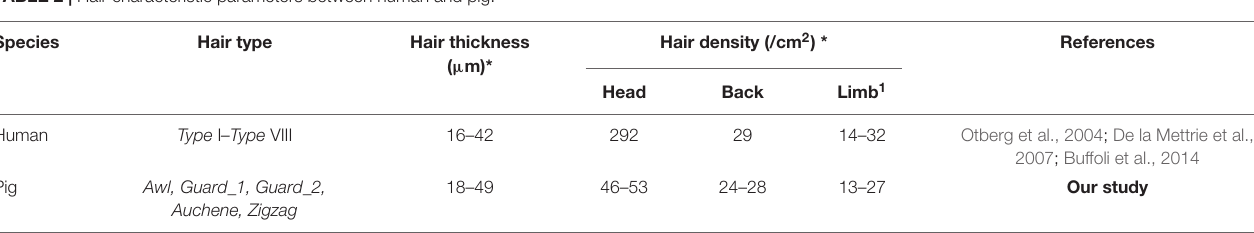
FIGURE 5 | The hair types between pig and human scalp hair. (A) CD meter used in the determination of five pig hair type curve diameter. (B) Number of waves (W) in five pig hair types. (C) Segmentation tree of eight human scalp hair; CD meter template derived from Bailey and Schliebe (1985); the graphics of the waves in (B) derived from De la Mettrie et al. (2007). (D) Distribution of hair types in country groups. TABLE 2 | Hair characteristic parameters between human and